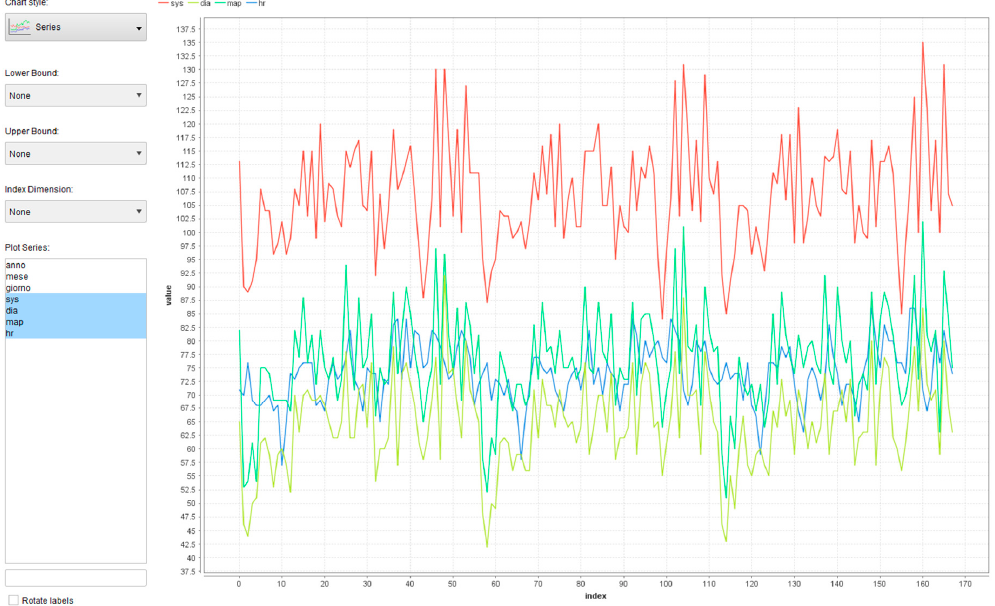
Figure 9. RapidMiner dashboard: experimental dataset.